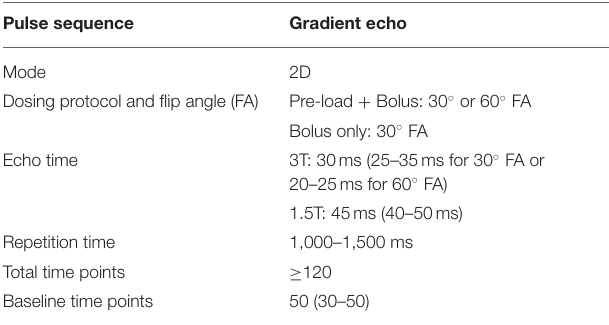
TABLE 1 | Consensus Guidelines for DSC MRI by Boxerman et al. (